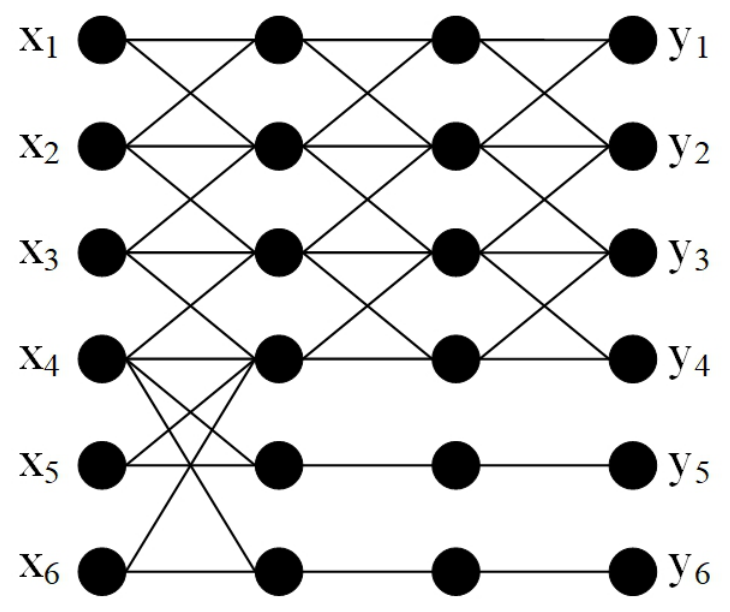
Figure 5. The graph-pruned structure of the P2N2